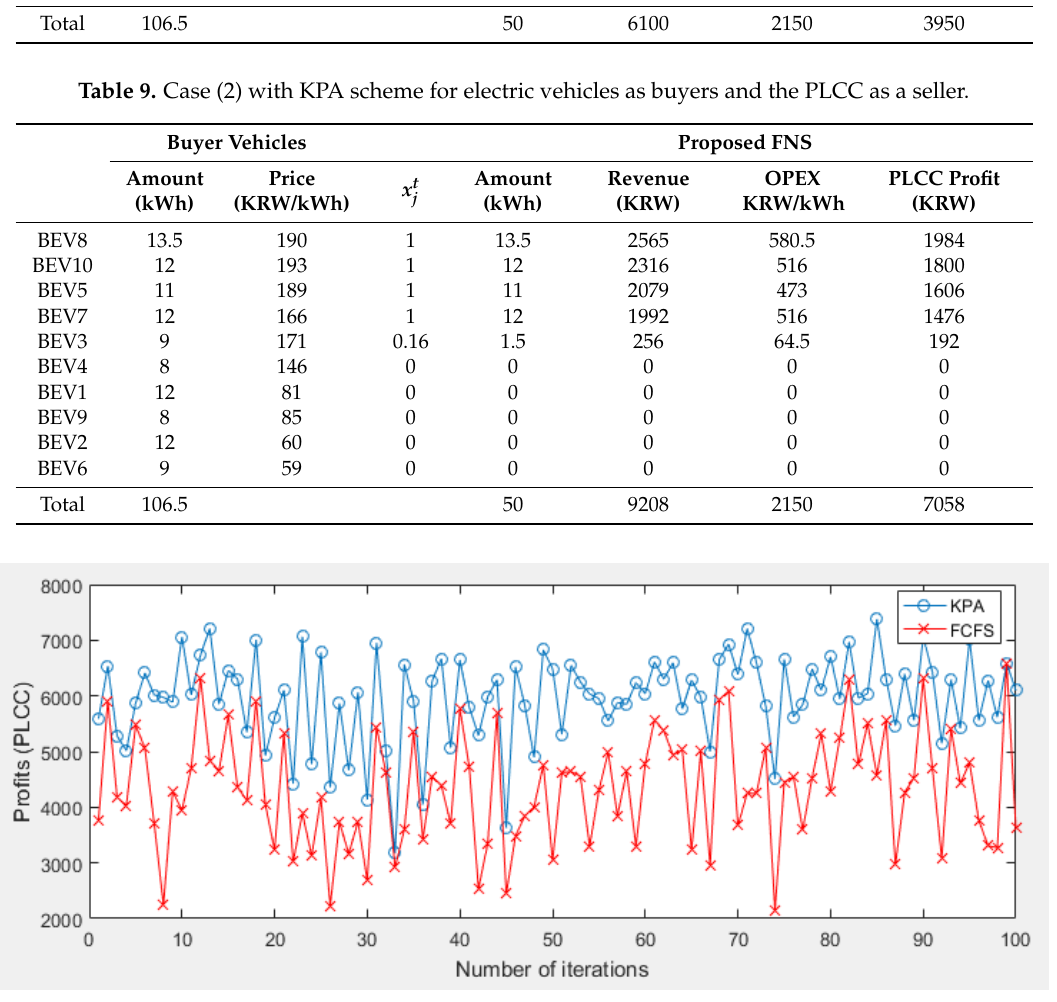
Figure 8. Results of total PROFIT for PLCC in Case (2): demand 50 kW, 10 EVs. Algorithm 2 Market Mechanism for Charging-Buyer Vehicles (BEVs)